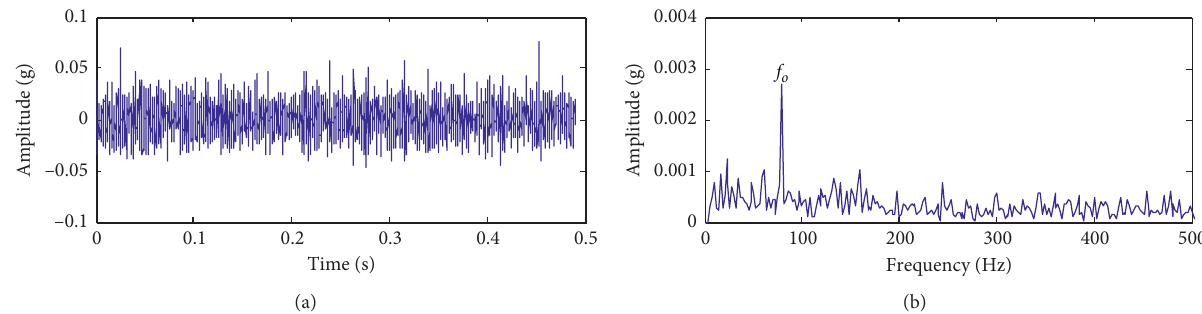
Figure 25: Comparison results of engineering signal by the MOMEDA method: (a) the waveform of deconvolution signal; (b) the envelope spectrum of deconvolution